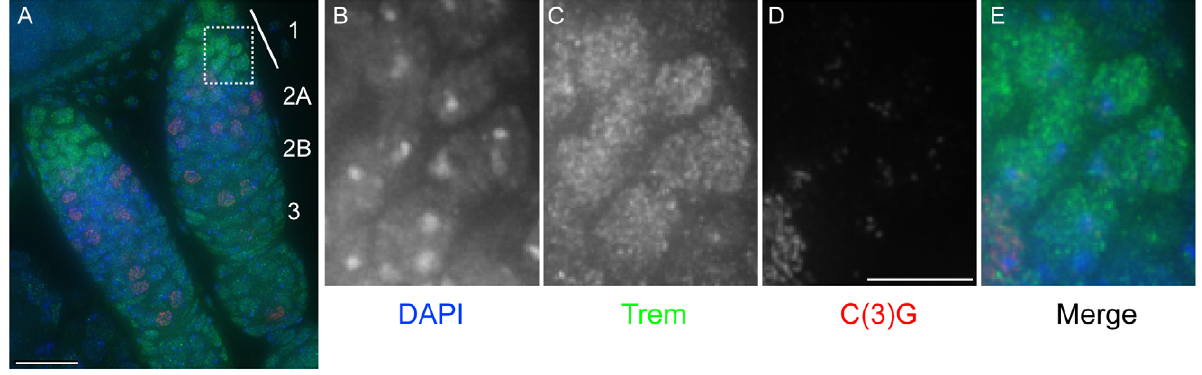
Figure 2. Trem’s localization pattern suggests it is a chromatin-associated protein. (A) Maximum intensity projection of deconvolved Z- series through whole mount germarium stained with DAPI and antibodies to Trem and C(3)G. Trem appears to be expressed in most cells within the ovariole (shown is through stage 2 only), but is enriched in region 1 of the germarium. (B–E) Higher magnification of cells within the dashed box in image (A). Cells correspond to a cyst in late region 1 (zygotene), and show that Trem is chromatin associated and highly expressed in cells prior to the time full length SC is visible within the cyst in region 2A. In D, the nucleus containing full length SC corresponds to a pro-oocyte from a region 2A cyst. Little or no Trem protein was detected in the oocyte nucleus after Stage 2 (data not shown). Scale bars, 15 m m (A) and 5 m m